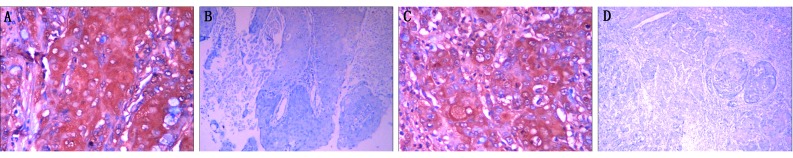
TSG101 and PEG10 expression in SC/ASC using EnVision immunohistochemistry; original magnification, ×200. TSG101- and PEG10-positive reactions were mainly localized in the cytoplasm. (A) Positive TSG101 expression (>25% positive cells) in moderately-differentiated SC/ASC. (B) Negative TSG101 expression (<25% positive cells) in well-differentiated SC/ASC. (C) Positive PEG10 expression in poorly-differentiated SC/ASC. (D) Negative PEG10 expression in moderately-differentiated SC/ASC. TSG101, tumor susceptibility gene 101; PEG10, paternally expressed gene 10; SC/ASC, squamous cell/adenosquamous carcinoma.